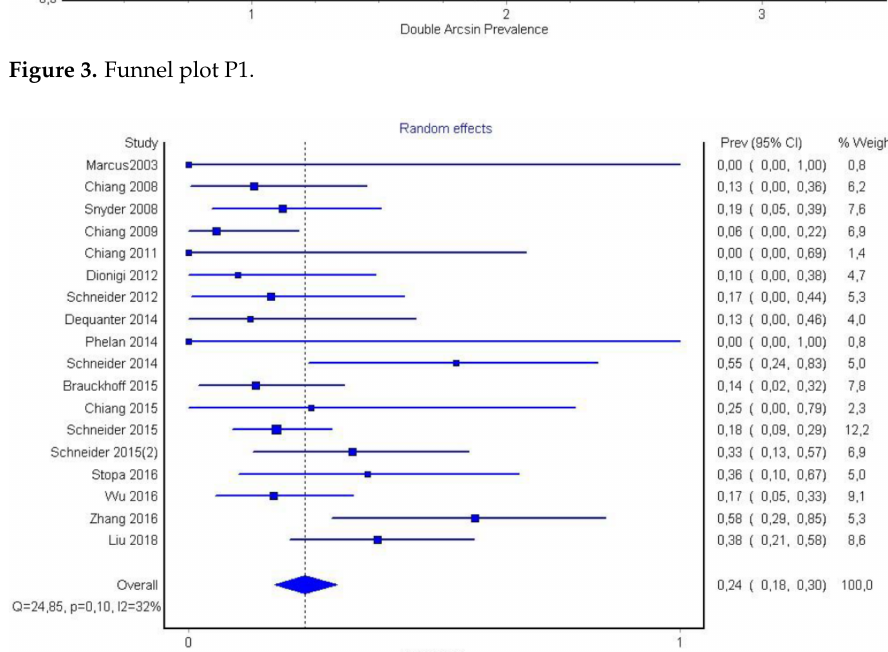
Figure 4. Forest plot